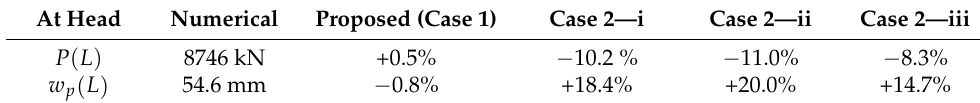
Table 3. Summary of percentage deviation from the FE results. At Head Numerical